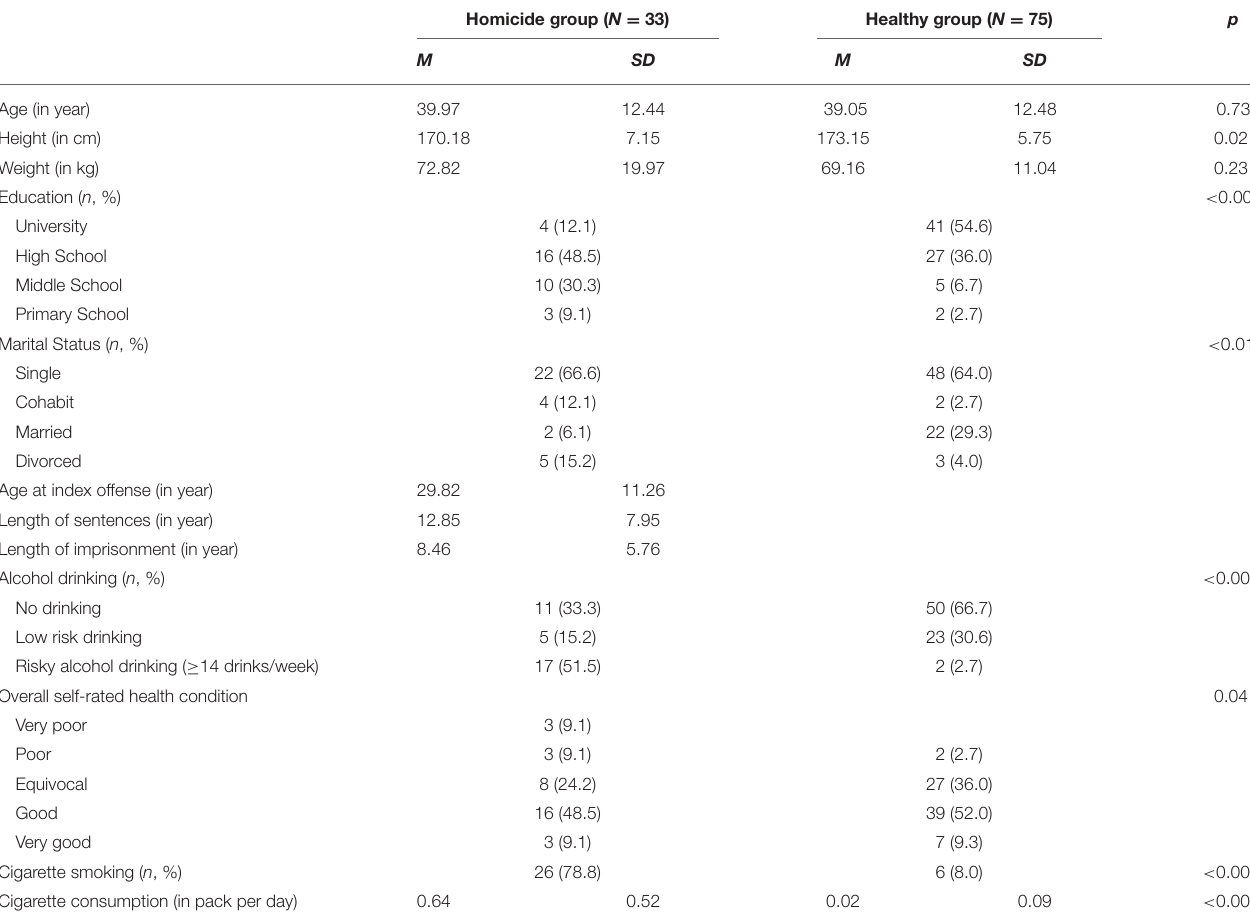
TABLE 1 | Demographic characteristics of all